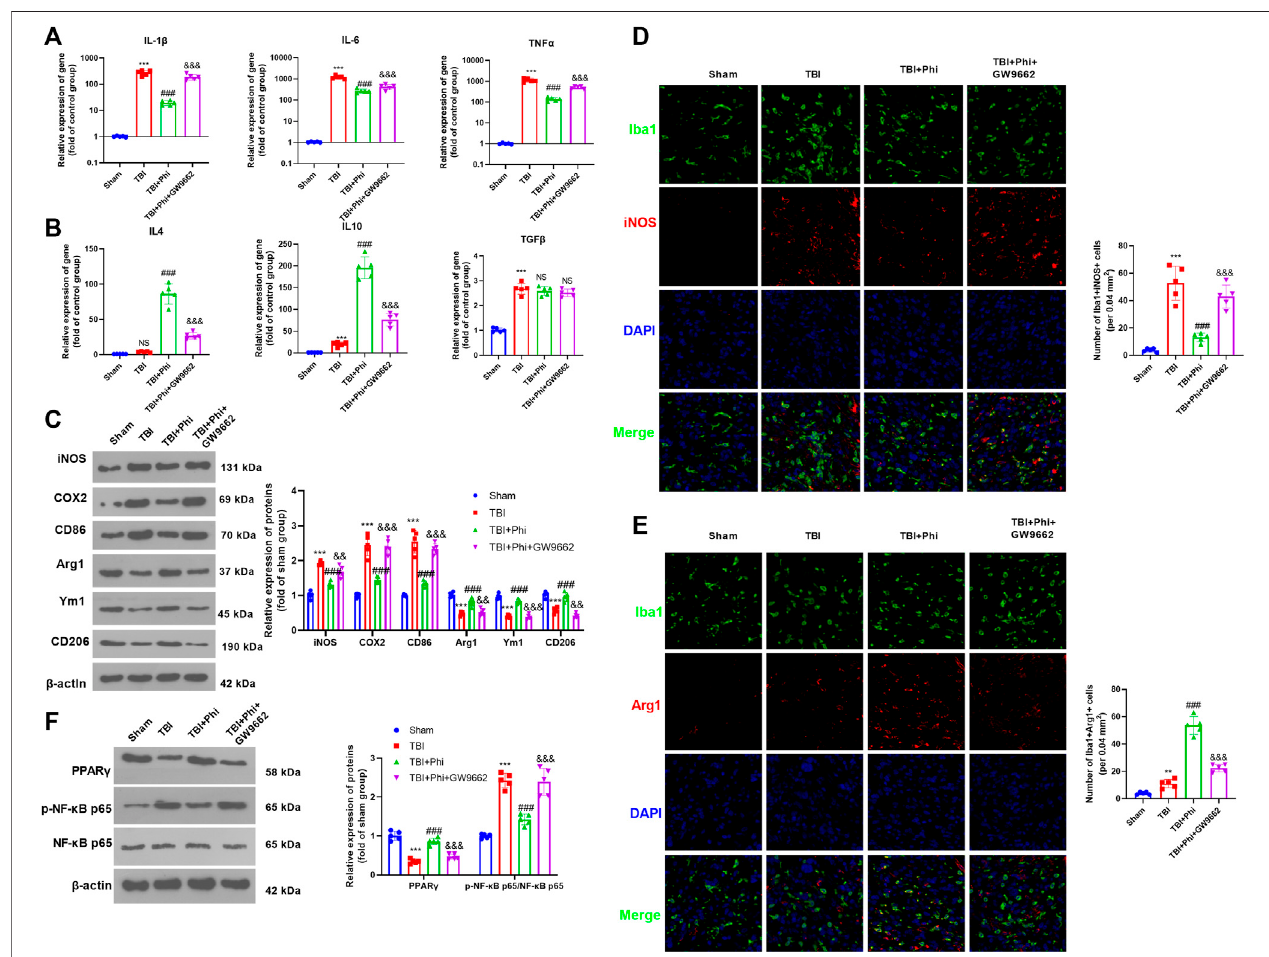
FIGURE 6 | Phi inhibited the in fl ammatory response of TBI-activated microglia. The TBI mouse model was constructed. The mice subjected to TBI were treated with Phi (10 mg/kg) and, or GW9662 (1 μ mol/kg) 1 h before surgery and thereafter daily for seven days by intraperitoneal injection. The same volume of the solvent was givenforthemiceintheTBIorshamgroup. (A , B) RT-PCRwasconductedtomeasureIL-1 β ,IL-6,TNF α ,IL-4,IL-10,andTGF- β inthebrainlesionsseven daysafterTBI. (C) Western blot was conducted to detect the protein levels of iNOS, COX2, CD86, Arg1, Ym1, and CD206 in TBI lesions seven days after TBI. (D , E) Immuno fl uorescence was used to detect Iba1 + iNOS + and Iba1 + Arg1 + microglia in the brain lesions seven days after TBI. (F) Western blot was conducted to measure phospho-NK- κ B p65 and PPAR- γ in the brain lesions seven days after TBI. The values are expressed as mean ± SD. NS p > 0.05, *** p < 0.001 vs. the sham group; NS p > 0.05, ### p < 0.001 vs. the TBI group; NS p > 0.05, && p < 0.01, &&& p < 0.001 vs. the TBI+Phi group. n (cid:1)